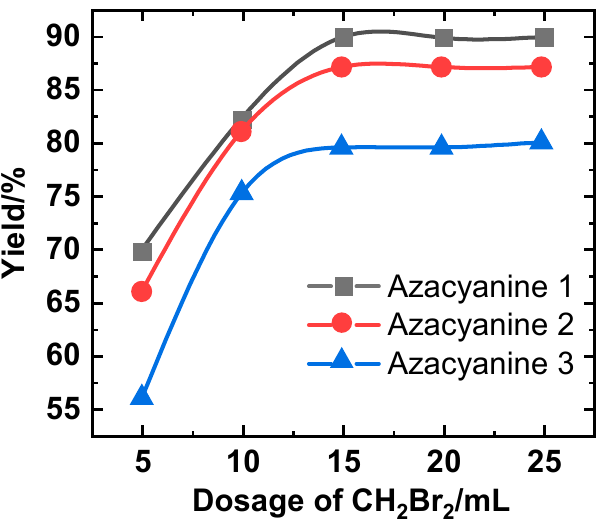
Figure 3. The effect of dibromomethane dosage in the production of azacyanine derivatives: Azacyanine 1 (black), Azacyanine 2 (red), and Azacyanine 3 (blue).